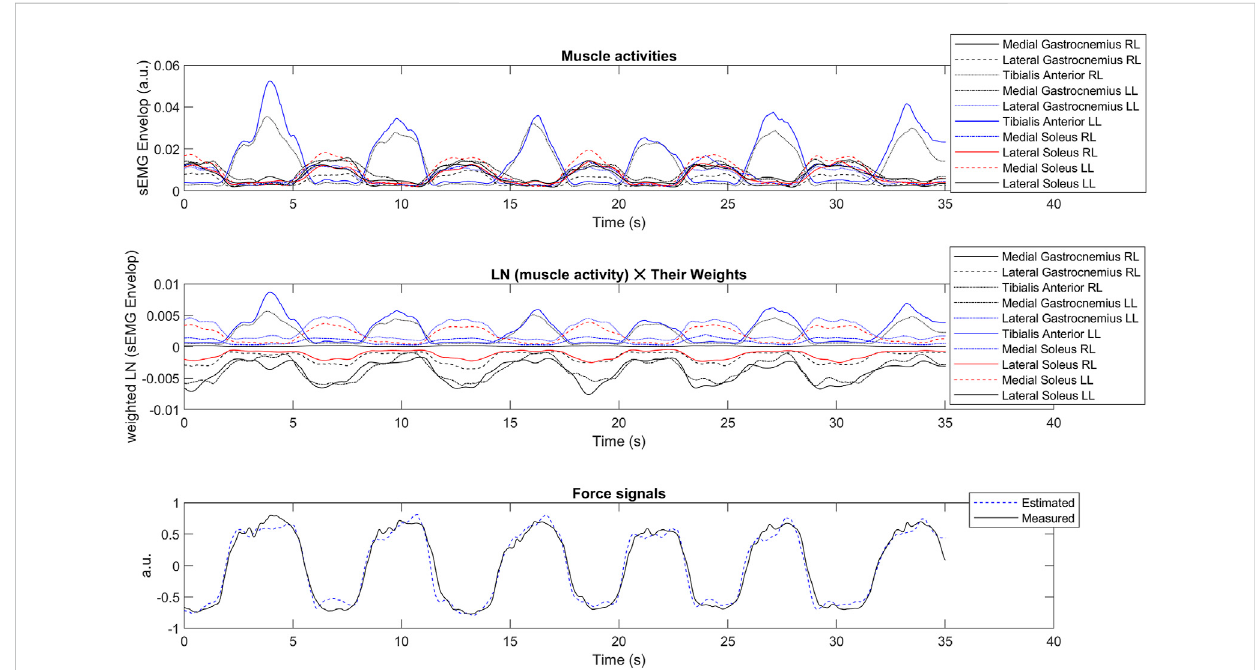
FIGURE 10 The envelope of the sEMG signal (top), the weighted activity of each muscle estimated from Eq. 7 (middle), and the estimated v.s. measured force signals(bottom)inasampledatafromthelower-limbtestdataset(50%hold-outvalidation).They-labeldatahasnormalizedarbitraryunit(a.u.).RL:Right Leg; LL: Left Leg; LN: Natural